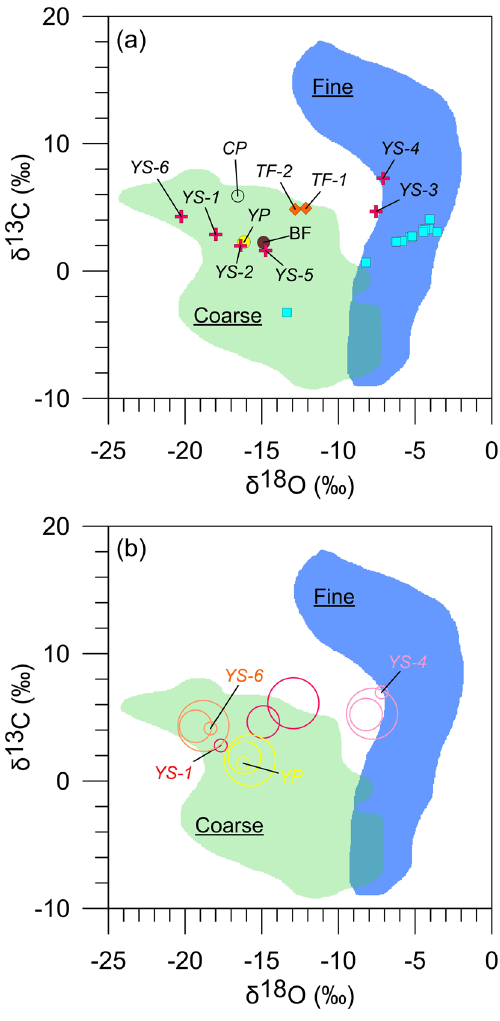
Figure 3. ( a ) Isotope data for samples from WWC: blue squares are bedrock; red crosses are CCC from the ice surface; CP and YP are CCC from the “clear” and the “yellow” pools, respectively; BF is from a layer of CCC within the perennial ice body. The blue and green fields delineate the typical range of isotope values for CCC fine and CCC coarse after 28 . ( b ) Isotope values for samples YS-1, YS-4, YS-6, and YP presented by size fraction: large circle, 165–250 µm; medium circle, 75–165 µm; small circle, < 75